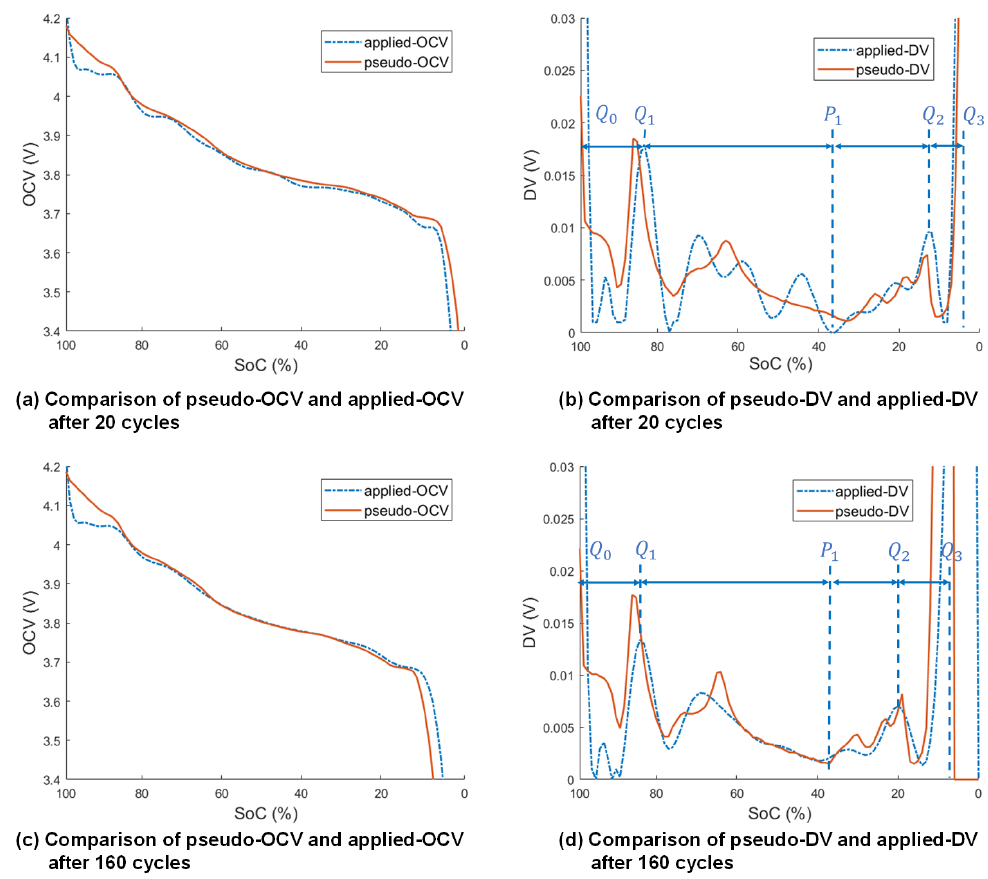
Figure 20. Comparisons of pseudo-OCV/DV curves and applied-OCV/DV curves after 20 and 160 cycles. ( a ) Comparison of pseudo-OCV and applied-OCV/DV after 20 cycles; ( b ) comparison of pseudo-DV and applied-DV after 20 cycles; ( c ) comparison of pseudo-OCV and applied-OCV/DV after 160 cycles; ( d ) comparison of pseudo-DV and applied-DV after 160 cycles. Table 4. Extracted features from the applied-DV curves under different